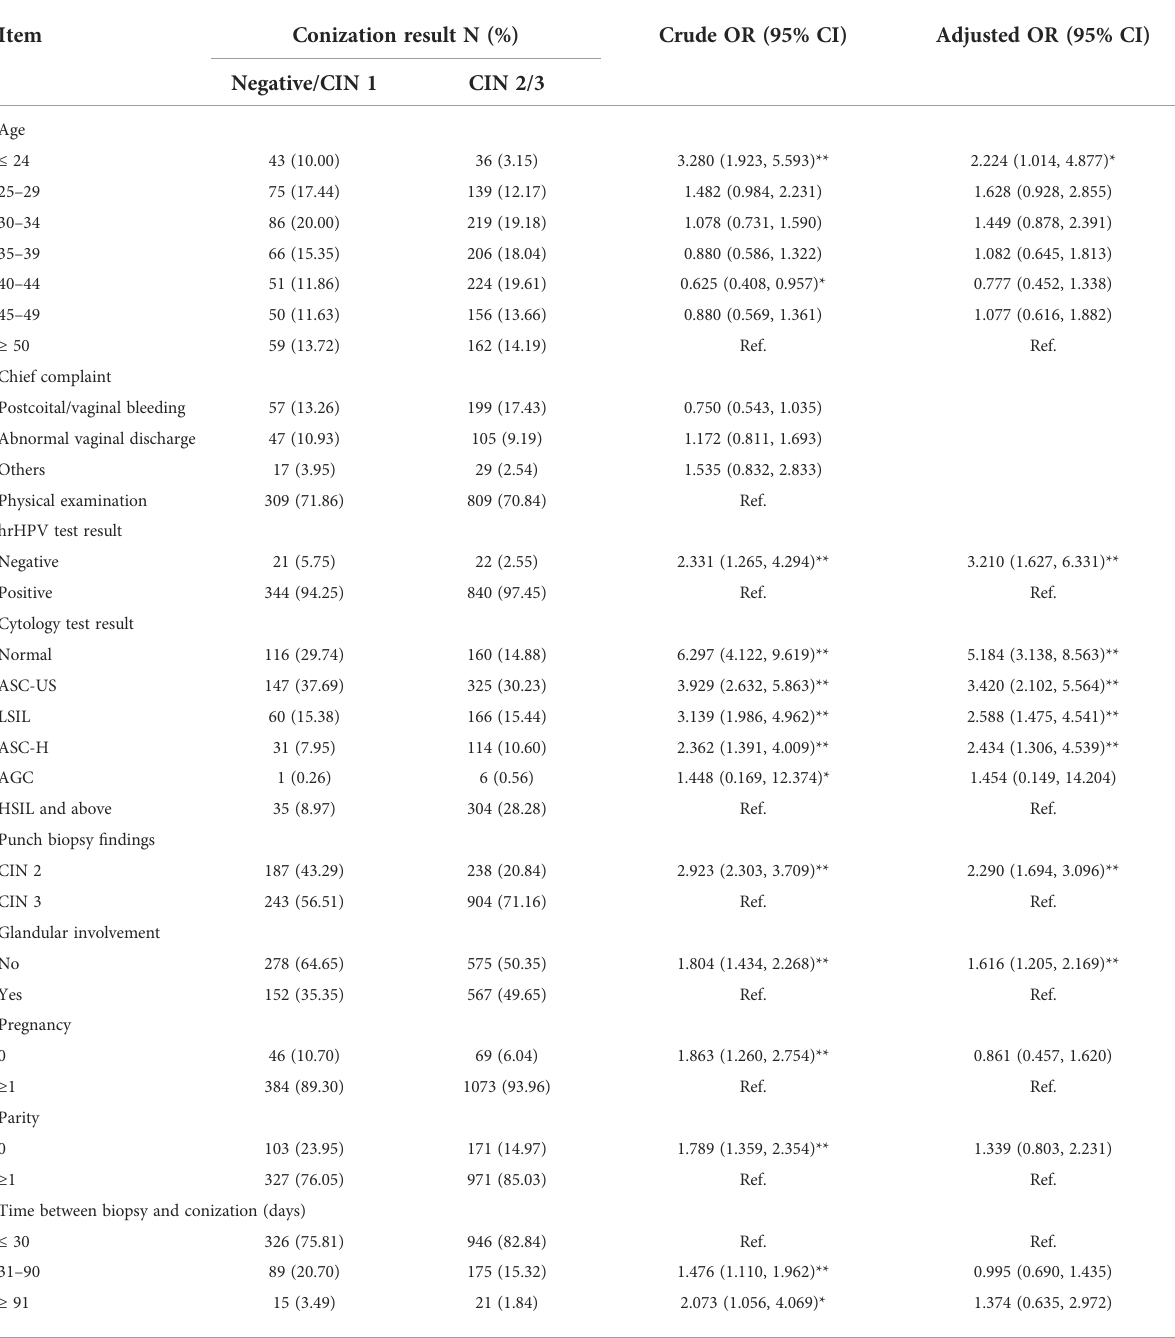
TABLE 2 Logistic regression analysis (OR and 95% CI) for absence of high-grade dysplasia in conization